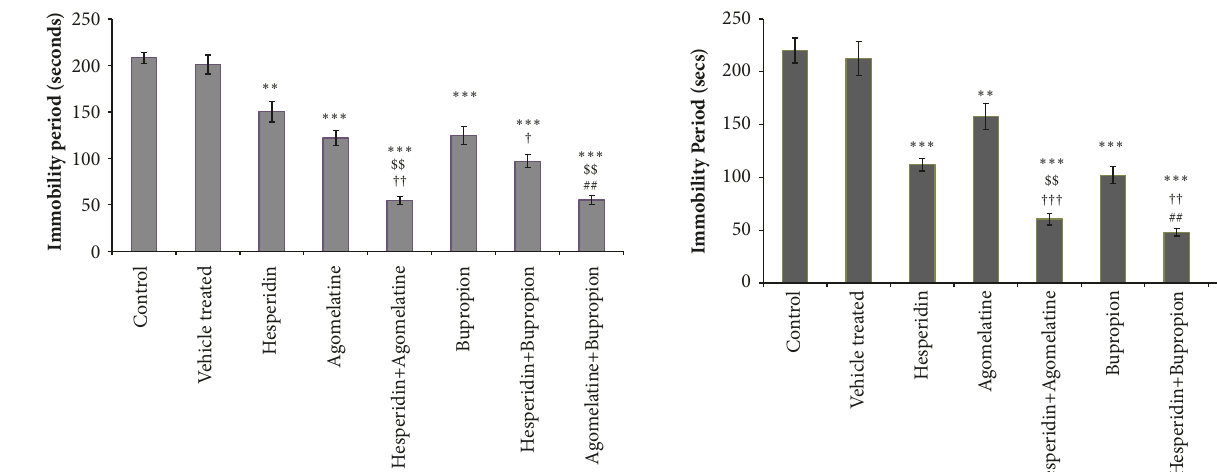
Figure 1: Forcedswim test. Significant differenceis denoted by ∗∗∗ P < 0.001 and ∗∗ P < 0.01 as compared to control group; $$ P < 0.01 as compared to agomelatine treated group; †† P < 0.01 and † P < 0.05 as compared to hesperidin treated group; ## P < 0.01 as compared to bupropion treated group.